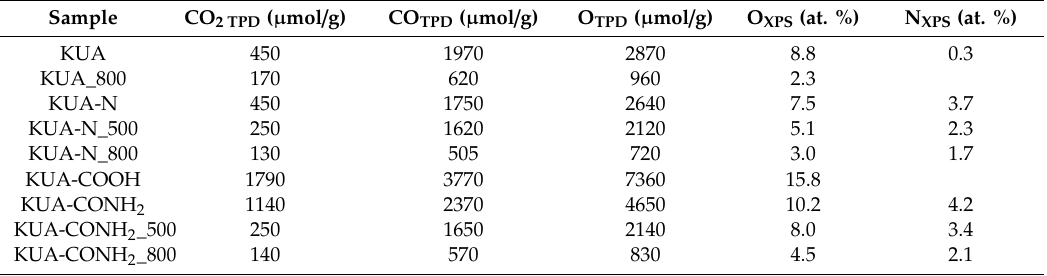
Table 2. Surface composition of the activated carbons obtained by XPS and